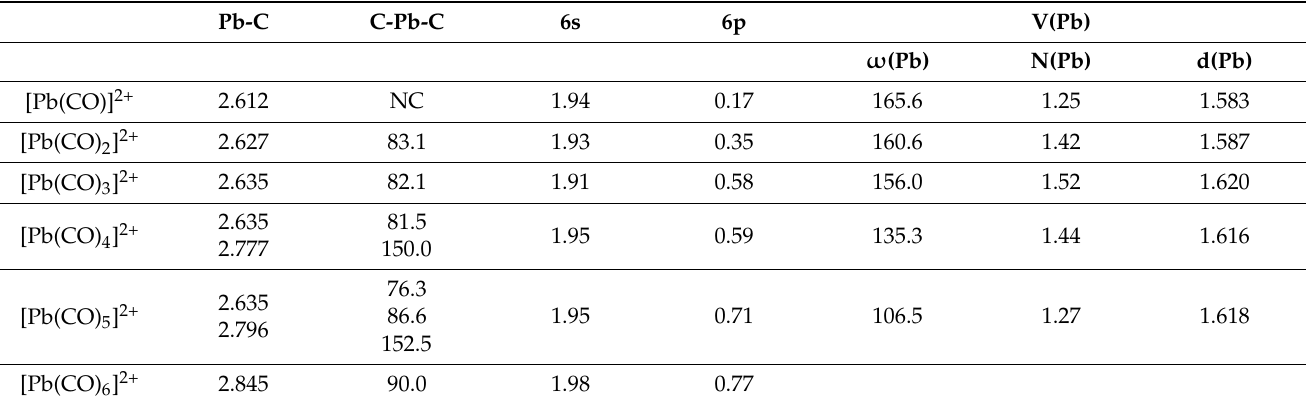
Table 1. Properties of the [Pb(CO) n ] 2+ complexes. Pb-C bond lengths in Angstroms. C-Pb-C angle in degrees. Electronic population of the 6s and 6p shells of lead from NBO analysis. Volume ( ω (Pb) in Å 3 ), population (N(Pb) in electrons) of lead valence basin and distance (d(Pb) in Å) of the V(Pb) ELF attractor and